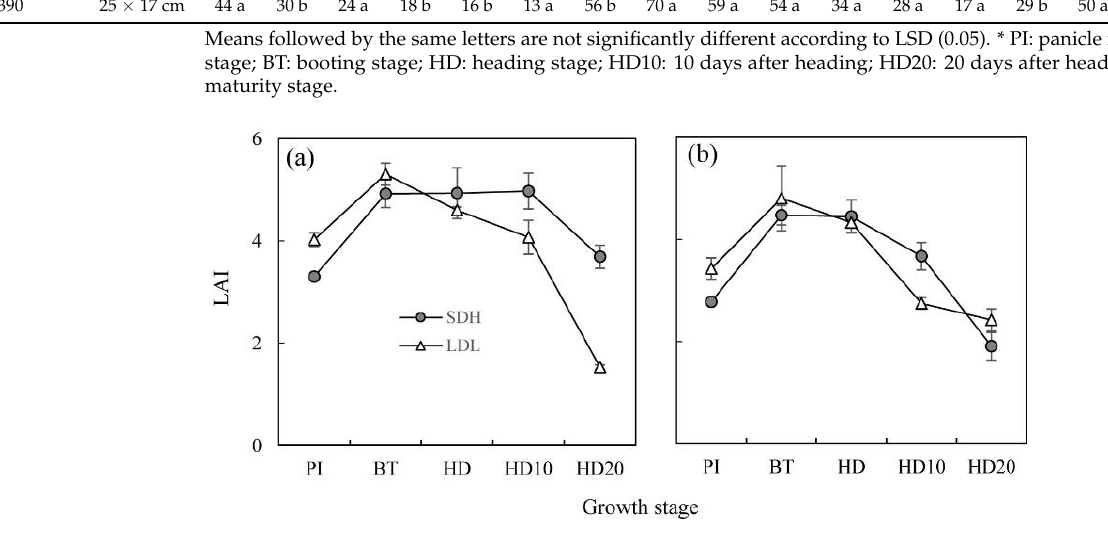
Figure 2. Leaf area index (LAI) of two growth-duration rice cultivars under two planting densities in 2018 ( a ) and 2019 ( b ). PI: panicle initiation stage; BT: booting stage; HD: heading stage; HD10: 10 days after heading; HD20: 20 days after heading.